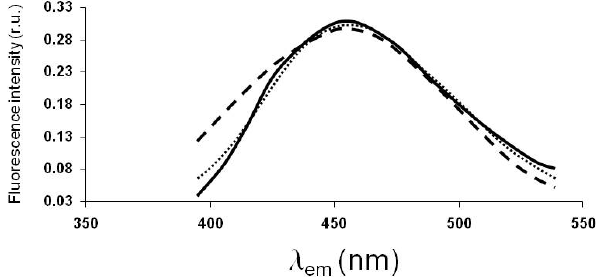
Fig. 2. Emission fluorescence spectra ( λ ex = 350nm) for the TQS sample (solid line) and model output with the asymmetric Gaus- sian distribution (dotted line) and the classic Gaussian distribution (dashed